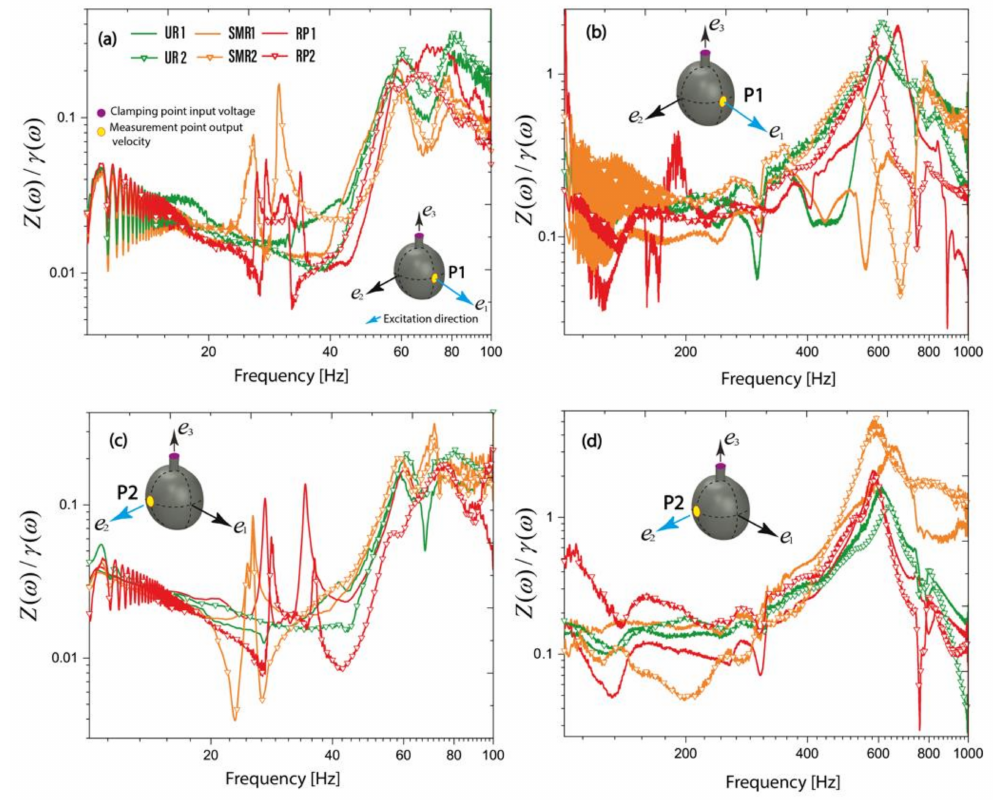
Figure 9. Scaled mechanical impedance. ( a ) 10–100 Hz for P1, ( b ) 100–1000 Hz for P1, ( c ) 10–100 Hz for P2, ( d ) 10–1000 Hz for